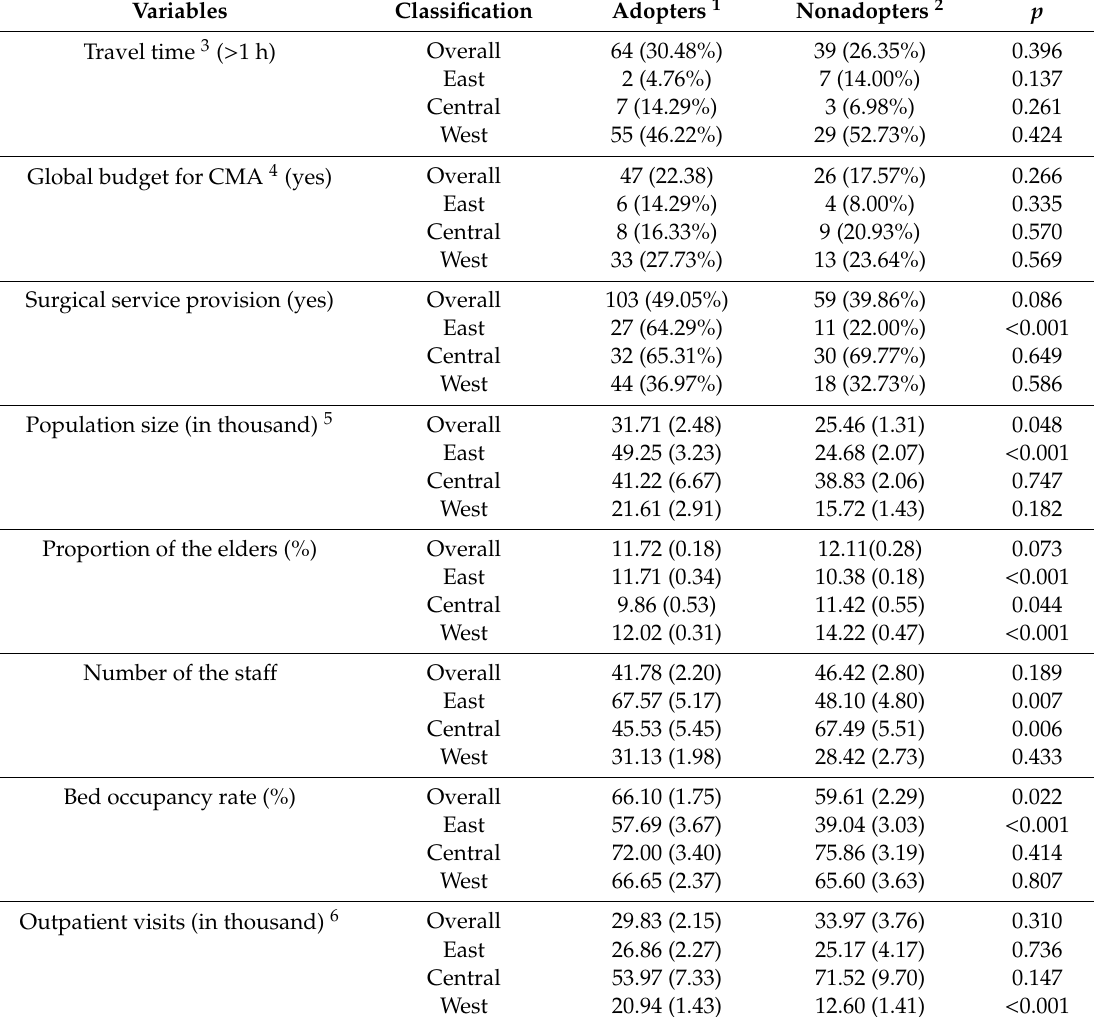
Table 3. Characteristics of the investigated township health centres between groups in di ff erent regions (frequency / mean ± percent /